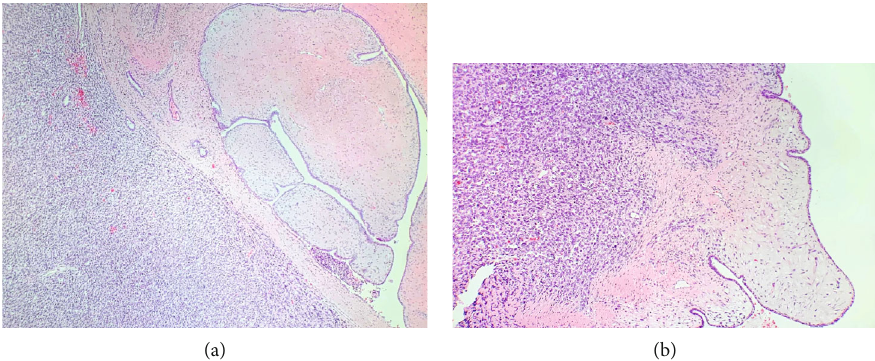
Figure 3: Malignant phyllodes tumor. (a, b) The characteristic leaf-like architecture with epithelium lined clefts is present (right) next to prominent hypercellular stroma (left) (H&E, × 40 (a), × 100 (b)).